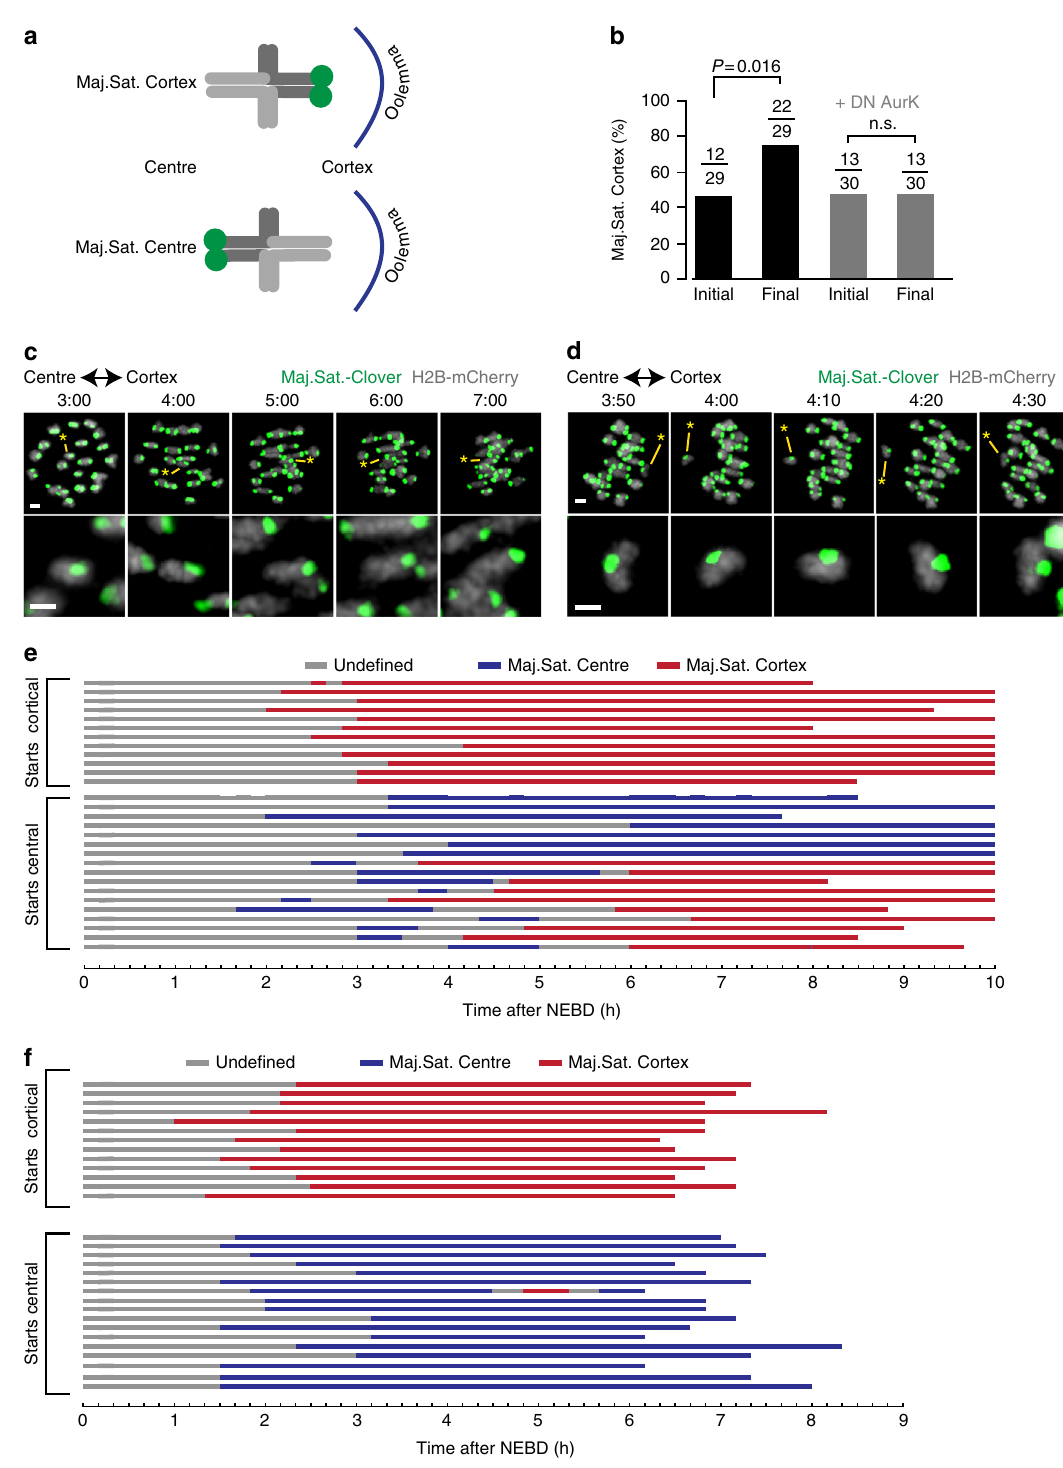
Fig. 2 Meiotic drive requires aurora kinase activity. a The driving bivalent was denoted as having the large Maj.Sat. signal facing towards either the oocyte cortex (Maj.Sat. Cortex) or centre (Maj.Sat. Centre). b Initial and fi nal bivalent orientation, measured at the time of fi rst bi-orientation (initial), and the frame immediately before anaphase ( fi nal) in oocytes treated with or without the DN-aurora kinase C construct ( P values from Fisher ’ s exact test). Numbers of bivalents examined are given, with two independent experiments using the construct and fi ve without. c , d Representative images of an oocyte expressing H2B-mCherry (grey) and Maj.Sat.-mClover (green), displaying the driving bivalent with persistent ‘ Maj.Sat. Cortex ’ orientation ( c ), and rotation from ‘ Maj.Sat. Centre ’ to ‘ Maj.Sat. Cortex ’ ( d ). The driving bivalent is indicated with an asterisk and enlarged in the lower image ( c , d ). Scale bars represent 2 µ m. Times are h:mm after NEBD. e , f Time course of driving bivalent orientation (Maj.Sat. Cortex, red; Maj.Sat. Centre, blue; unde fi ned, grey) from NEBD to anaphase or 10 h after NEBD as shown in ‘ c ’ and ‘ d ’ in the absence ( e ) or presence ( f ) of DN-aurora kinase C. Oocytes are sorted by the initial orientation of the driving bivalent (initial Maj.Sat. Cortex, top; initial Maj.Sat. Centre, bottom)